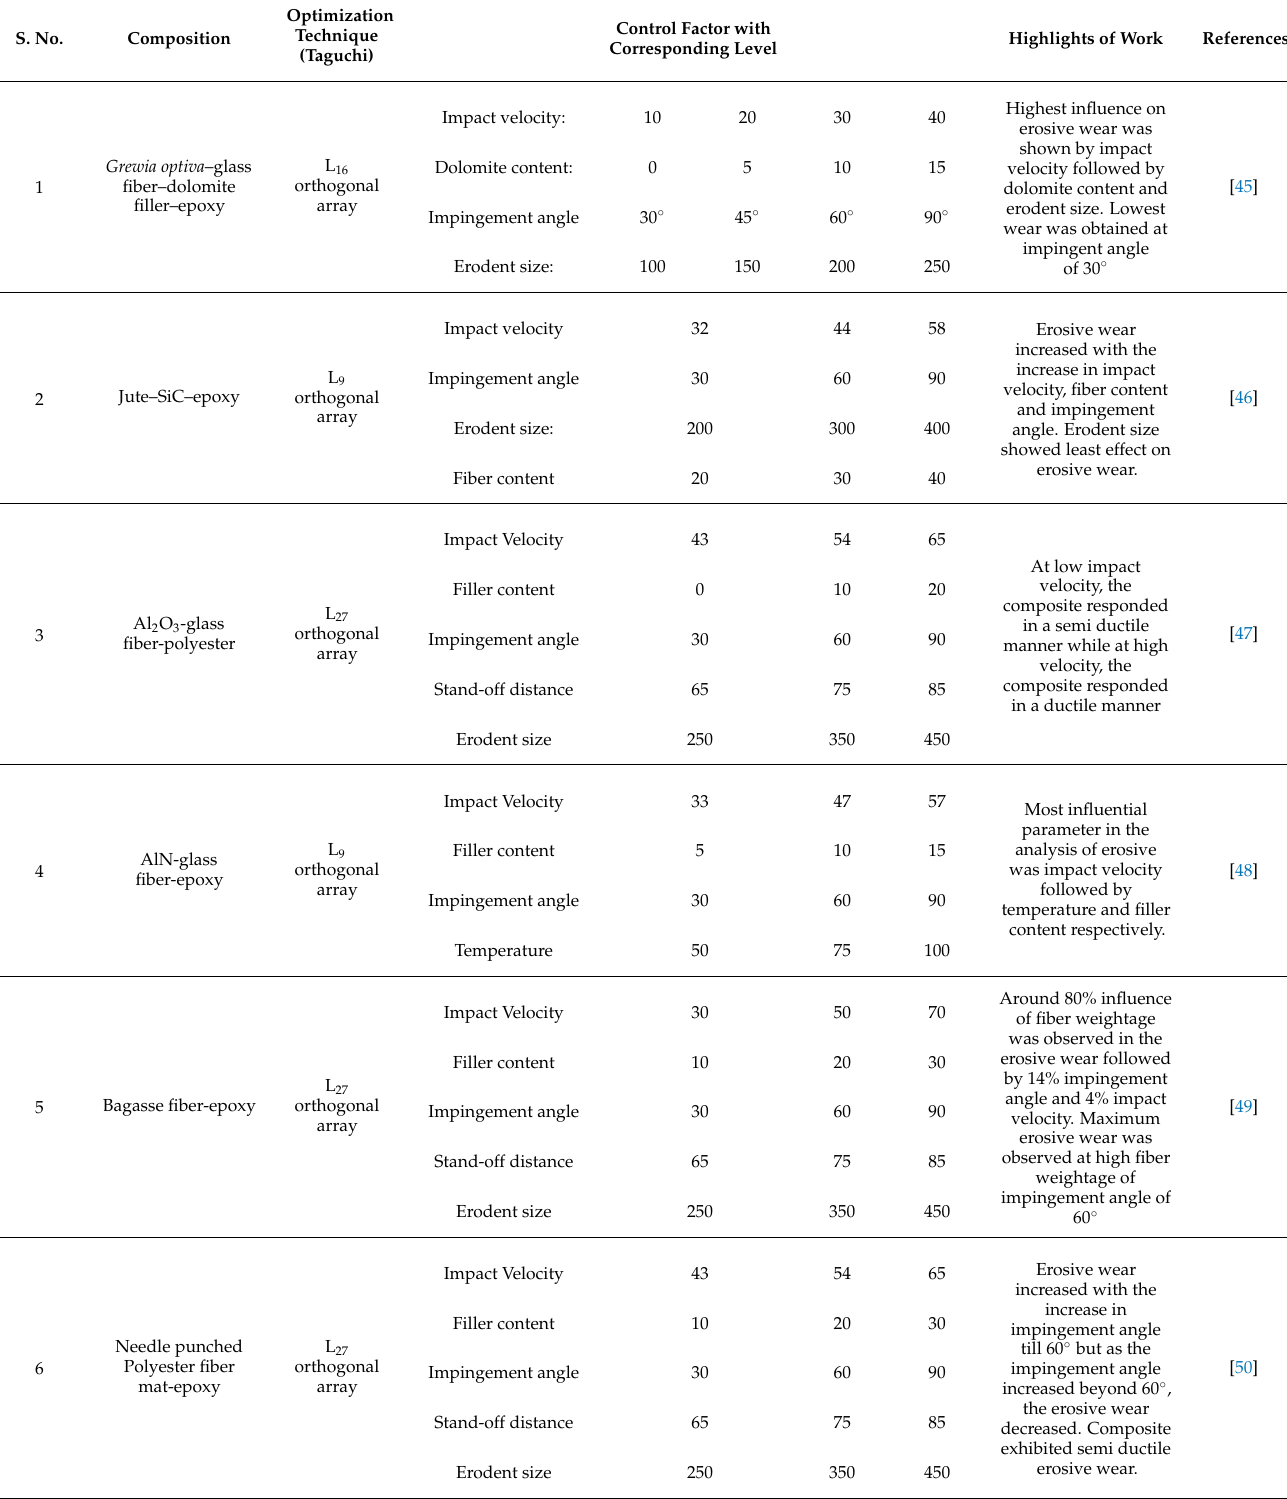
Table 4. List of work carried out for erosive wear using Taguchi